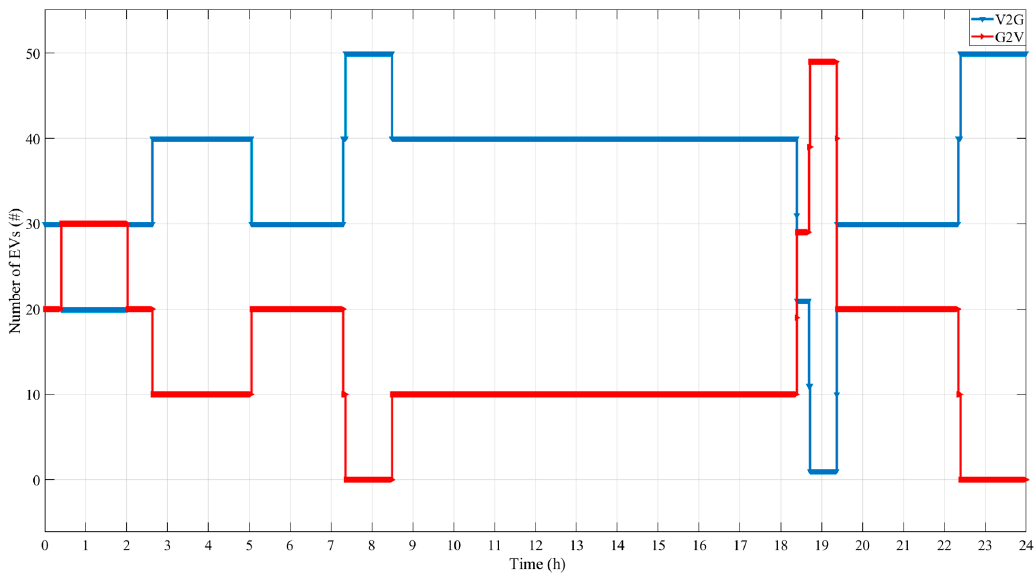
Figure 12. Time-based active power and voltage profile through the architecture (Scenario B): ( C1 ) voltage profile of the aggregator, ( C2 ) generated active power from PV, ( C3 ) injected active power from the aggregator (V2G), ( C4 ) Demand side, ( C5 ) the drawn active power from the architecture to the aggregator (G2V).